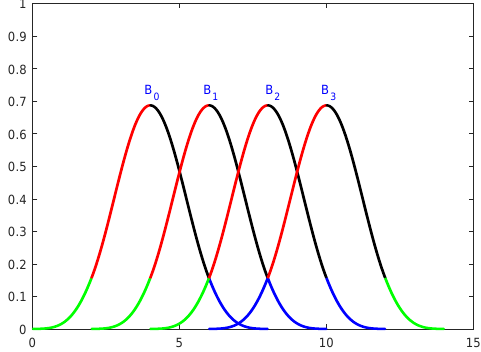
Figure 2. Cubic TBS basis functions at [ 0,14 )